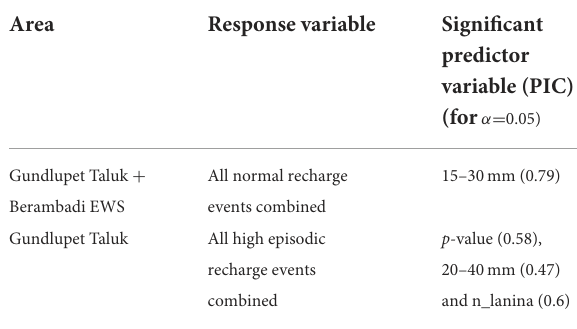
TABLE 1 Summary of high-episodic recharge events in Gundlupet taluk.